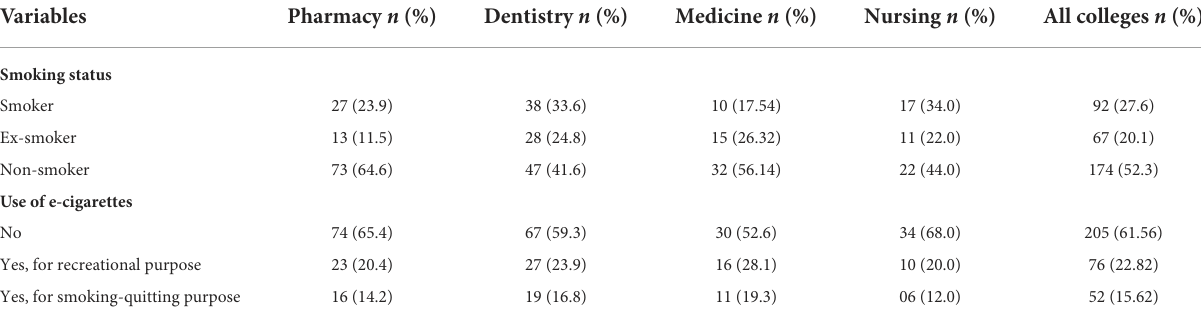
TABLE 1 Prevalence of smoking and use of e-cigarettes among the students of health care colleges ( n = 333). Variables